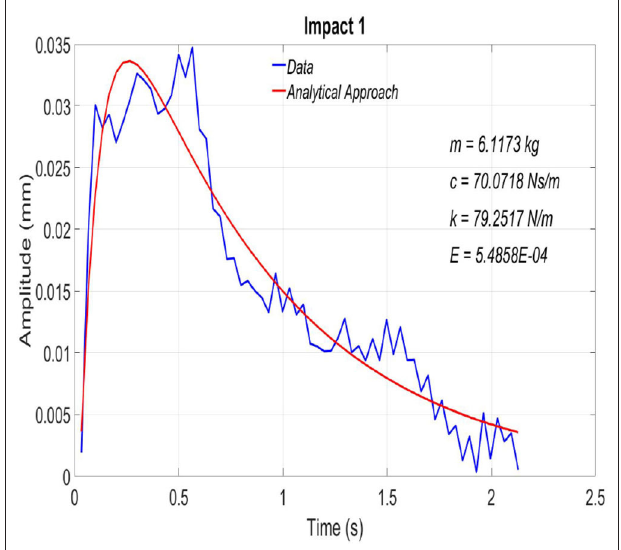
FIGURE 6 | Test 3, Optical characterization (blue) and Analytical results (red).